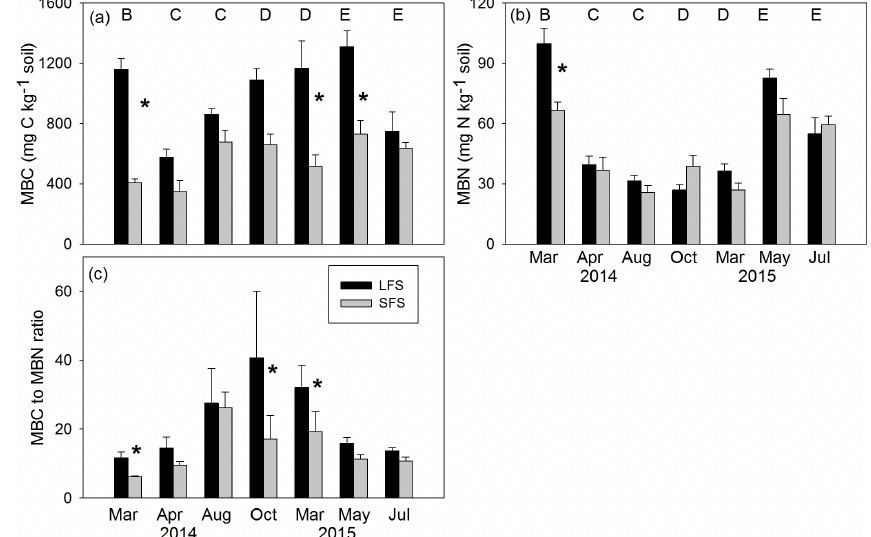
Figure 7. Seasonal variations in (a) MBC, (b) MBN and (c) MBC:MBN from the LFS and SFS measured at different sampling dates. Periods corresponding to different sampling dates are indicated by different letters (see Fig. 3). Vertical bars represent the standard errors of the mean ( n = 4–6). Asterisks indicate a significant difference between the LFS and SFS for the same sampling date ( P < 0 . 05). Table 2. Mean ± SE of soil NH + and NO − concentrations at 0–5cm depths (mgNkg − 1 ) for different sampling dates in 2014 and 4 3